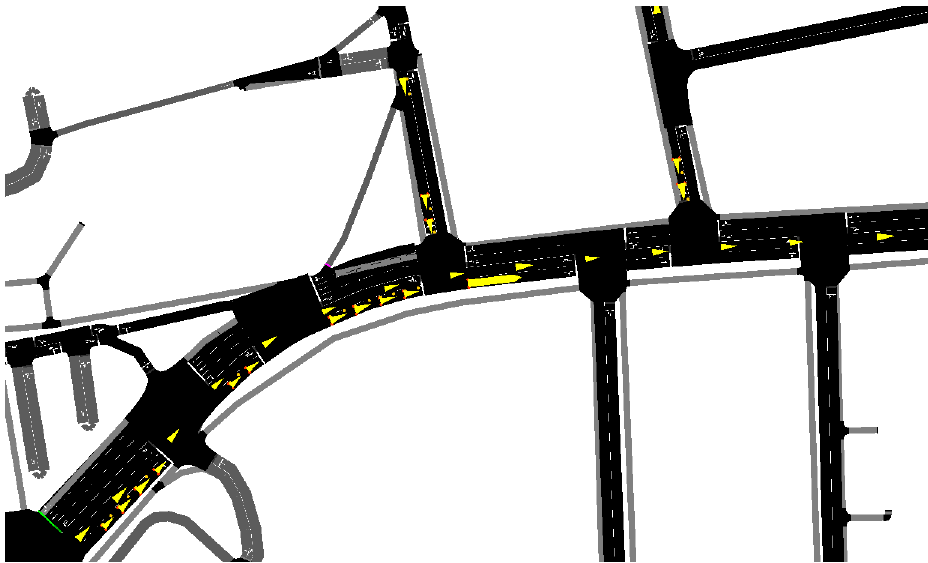
Figure 4. Urban traffic with platooning service use